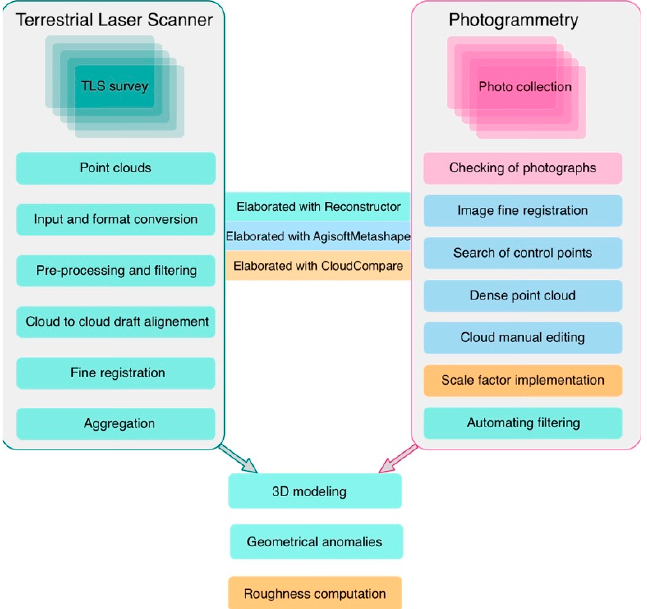
Figure 6. Flow chart representing the TLS and CRP data processes adopted in this work to compute high-resolution 3D models of the entire church and, subsequently, the three studied columns. The operations performed with JRC-3D Reconstructor ® version 4.1.2, Agistoft Metashape ® version 1.8.4, and CloudCompare version 2.12.4 software are highlighted in the figure with green, blue, and orange rectangles, respectively.